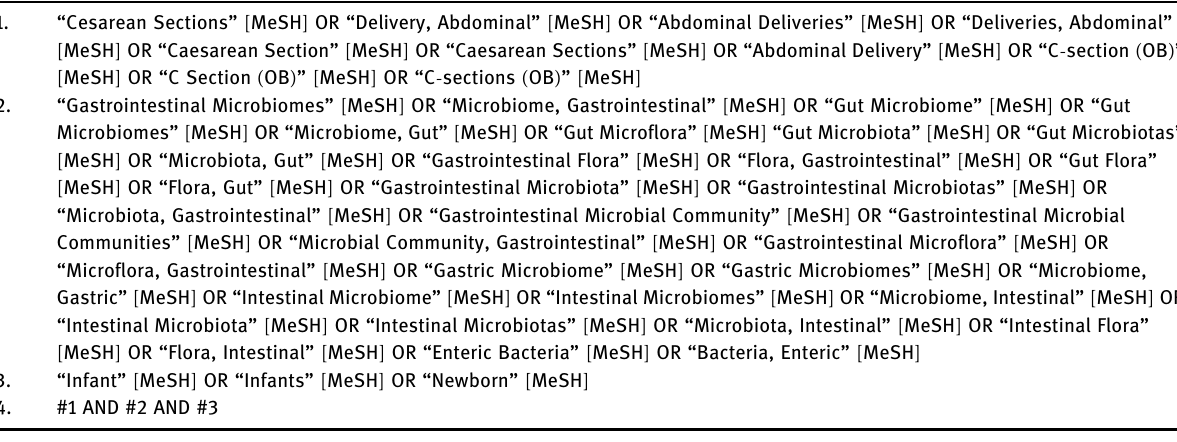
Table 1: Search strategies for systematic review